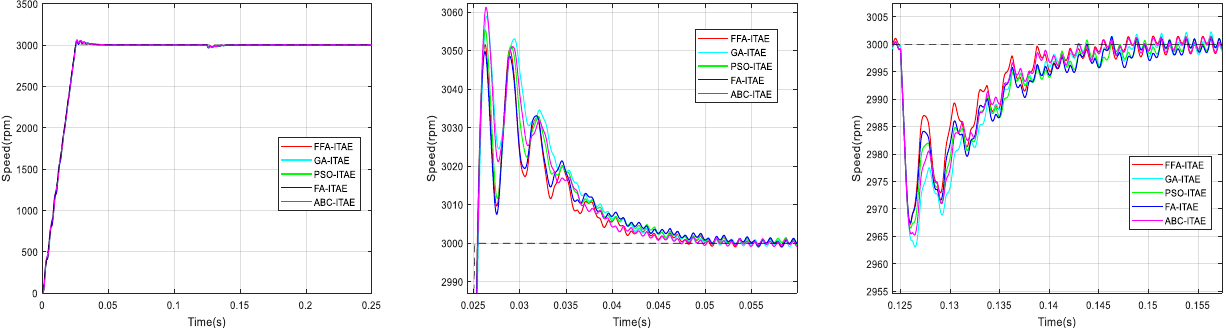
Figure 14. Comparison of speed responses with different algorithms using ITAE criterion: ( a ) original; ( b ) and ( c ) zoomed version.